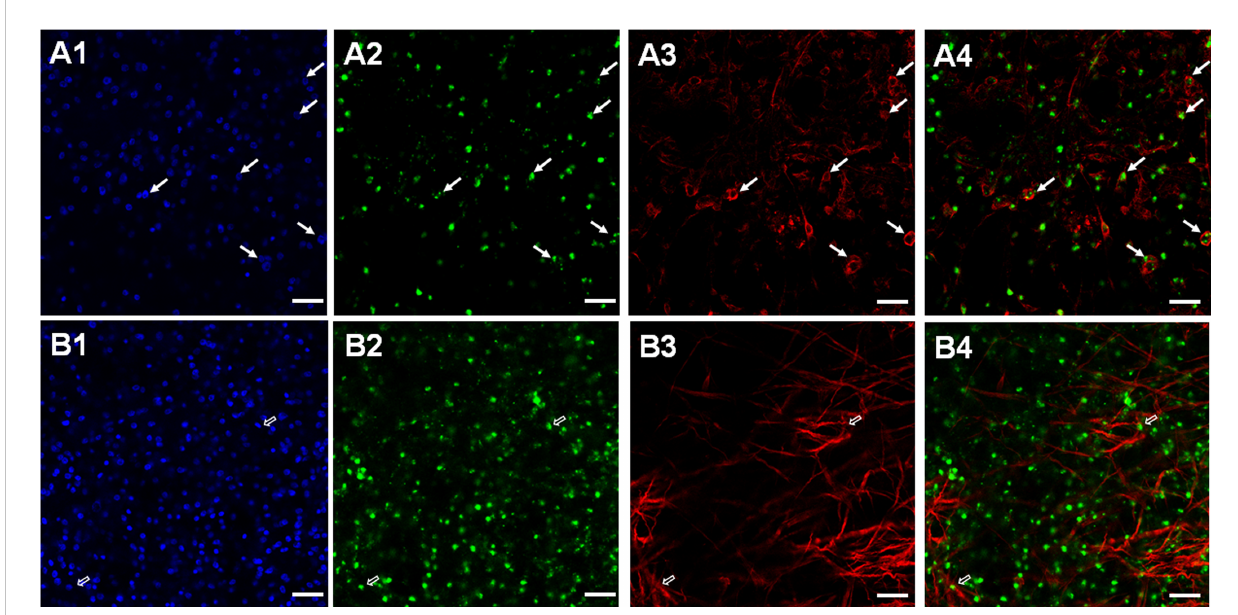
FIGURE 5 Expression of Echinococcus Emtr2 in nerve and muscle cells. Representative WISH images are shown for Emtr2 expression in nerve (A) and muscle (B) cells. Channels indicate DAPI (nuclei, blue; (A1, B1) ), Emtr2 -speci fi c probe (green; (A2, B2) ), anti-AcTub (nerve cells; (A3) ), and anti-HMW tropomyosin (muscle fi bers; (B3) ). Merges of all three channels are shown in (A4, B4) . Cells double positive for Emtr2 and AcTub are indicated by white closed arrows, cells positive for Emtr2 and HMW tropomyosin by open white arrows. Bar indicates 25